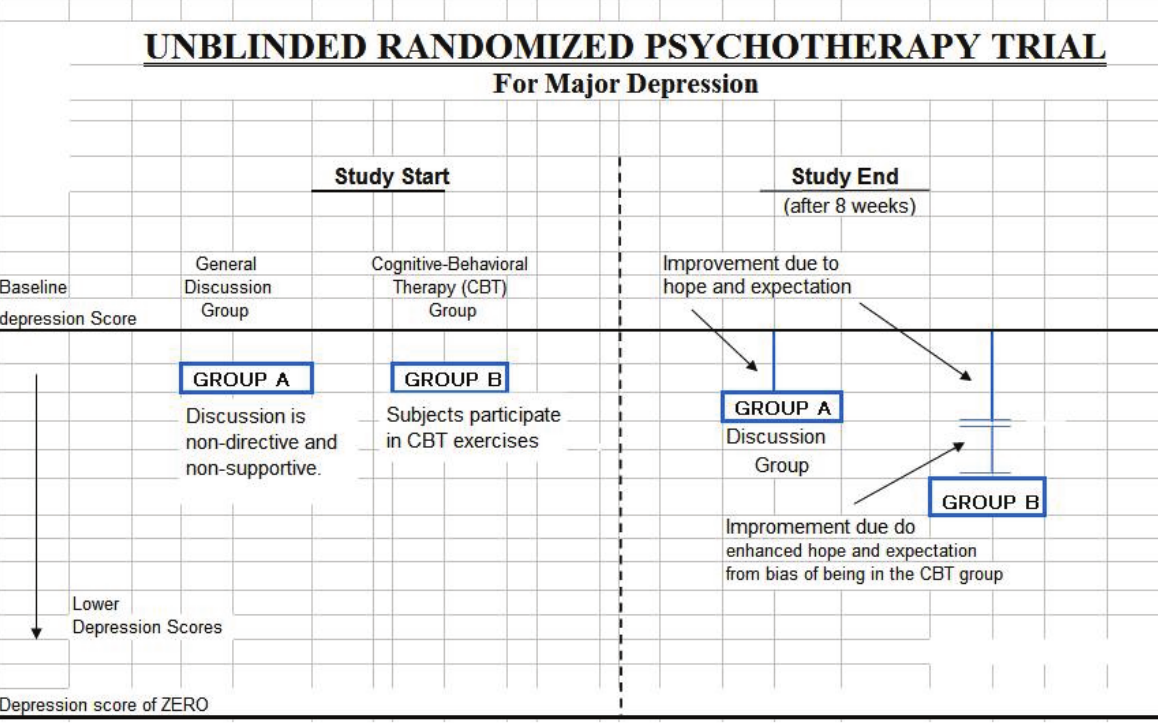
Figure 2. Unblinded randomized psychotherapy